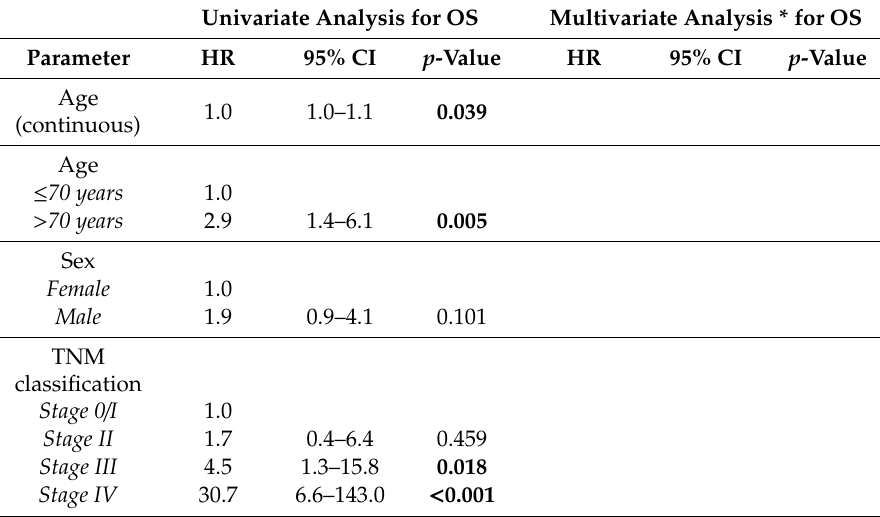
Table 3. Univariate and multivariate analyses of sCD163 serum levels for the OS of CRC patients Univariate and multivariate analyses for OS were generated for stage 0–IV CRC patients ( N = 64). The median sCD163 level (2.0 mg / L) was used as a cuto ff . Statistically significant p -values ( ≤ 0.05) are indicated in bold. Abbreviations: CI (confidence interval), CRC (colorectal cancer), HR (hazard ratio), OS (overall survival), sCD163 (soluble CD163), TNM (tumor, node,